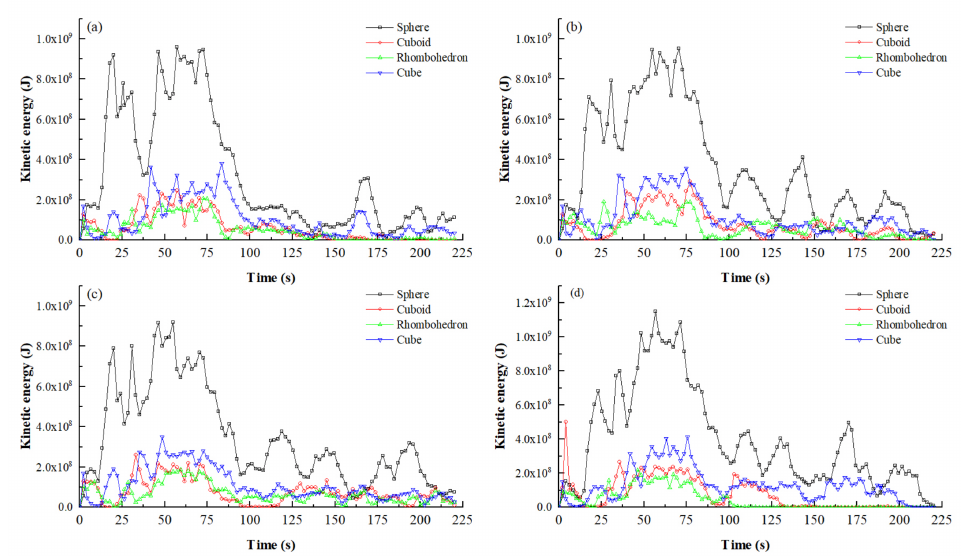
Figure 12. Influence of boulder shape on kinetic energy under different density conditions: ( a ) ρ = 1200 kg/m 3 , ( b ) ρ = 1500 kg/m 3 , ( c ) ρ = 1800 kg/m 3 , and ( d ) ρ = 2100 kg/m 3